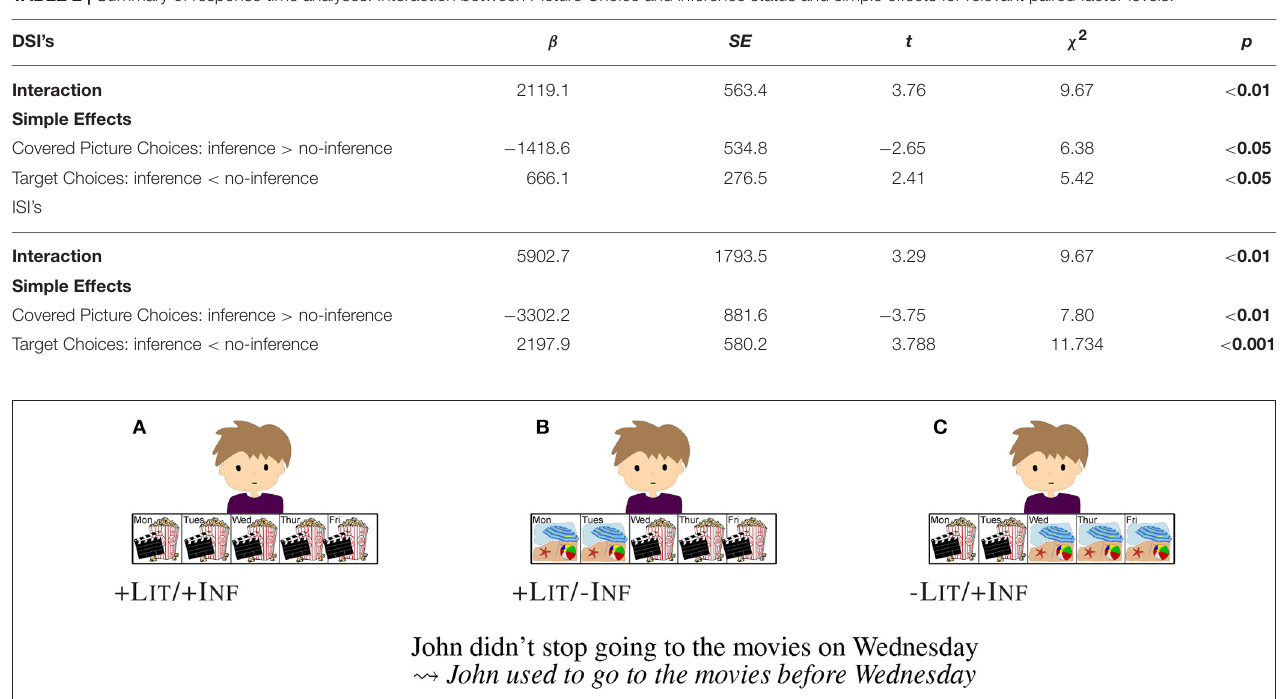
FIGURE 6 | Target Picture versions and conditions for Experiment Ib: “ + L IT / + I NF ” (A) , “ + L IT / − I NF ” (B) , “ − L IT / + I NF ” (C)